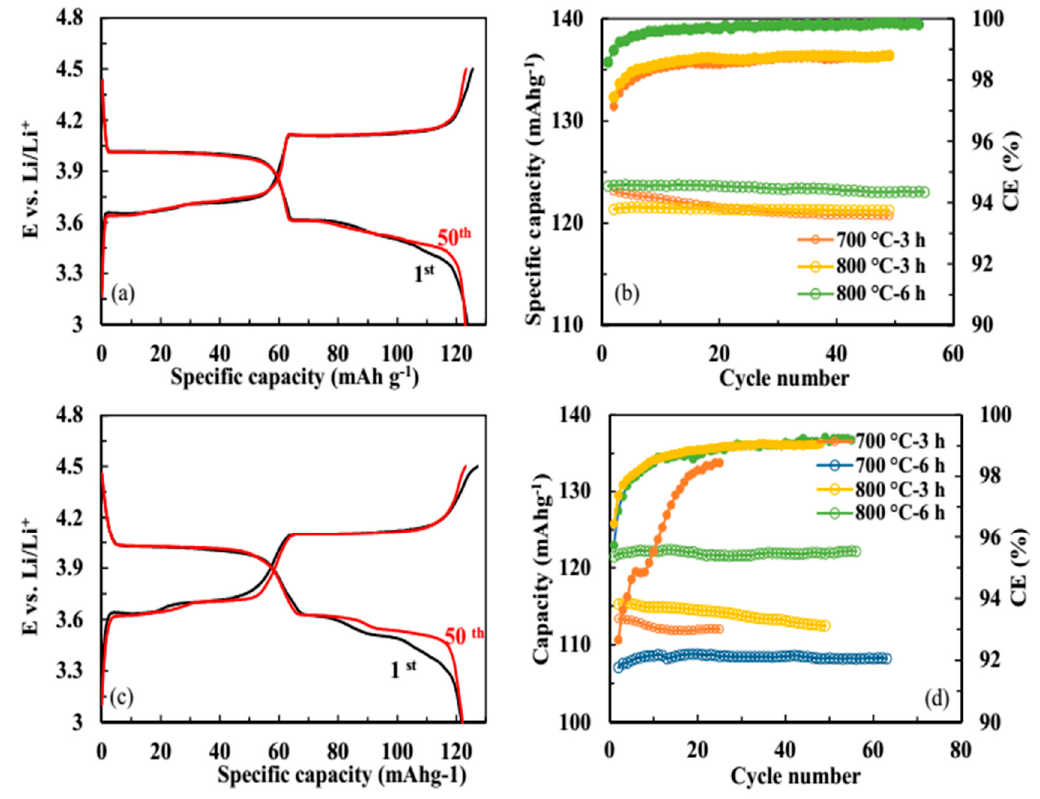
Figure 6. Initial and 50 th charge/discharge curves of the LVP compounds prepared by ( a ) oxalic acid and ( c ) citric acid and the cyclic performance of the LVP powders prepared by ( b ) oxalic acid and ( d ) citric acid, and potential (E) range of 3.0–4.3 V vs. Li.